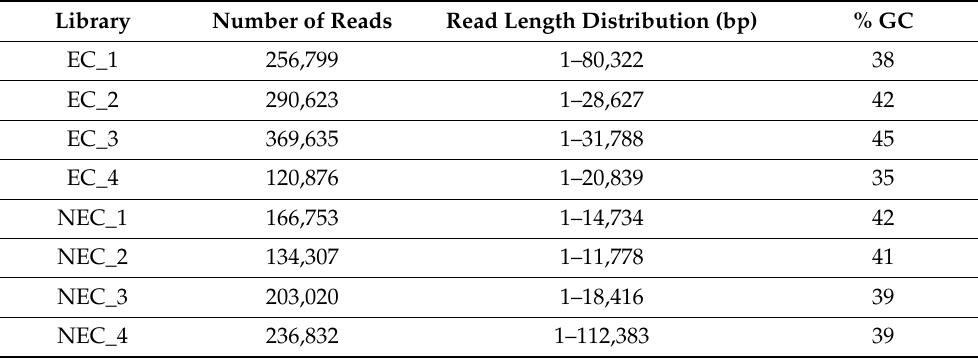
Table 1. Basic statistics from FastQC reports of raw data generated by MinION sequencing from Oxford Nanopore Technologies ® from barcoded cDNA libraries of S. betaceum compact embryogenic callus (EC) and friable non-embryogenic callus